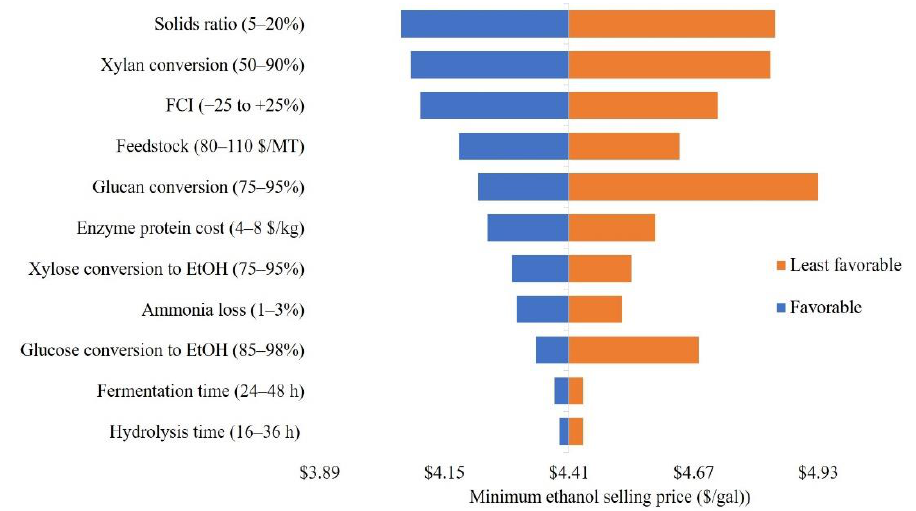
Figure 5. Sensitivity analysis for PT2 (PT2: 50 °C, 14 h, 14% ammonia) at high enzyme loadings for loose biomass.